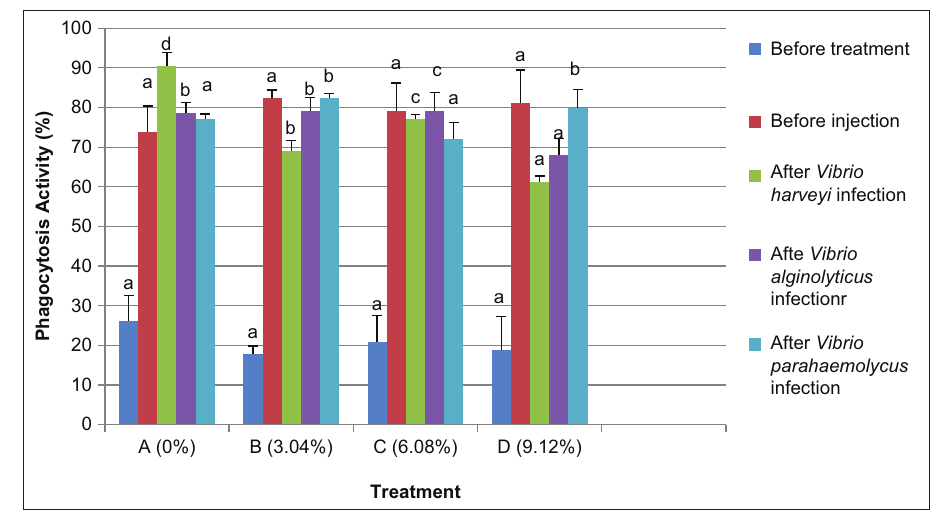
Figure-5: Phagocytosis activity of vannamei shrimp ( Litopenaeus vannamei ) before and after infected with Vibrio harveyi, Vibrio alginolyticus, and Vibrio parahaemolyticus and treatment with Majapahit ( Crescentia cujete L.) fruit powder. Data were indicated as mean value±SD. Graphs with different notations showed significantly different